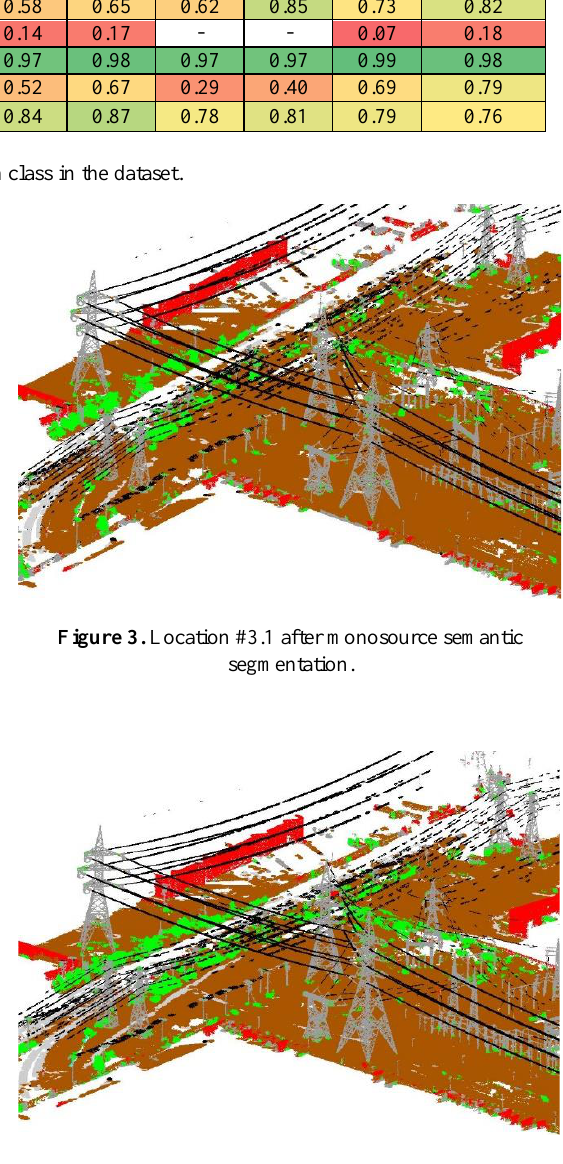
Figure 4. Location #3.1 after multi-source semantic segmentation.